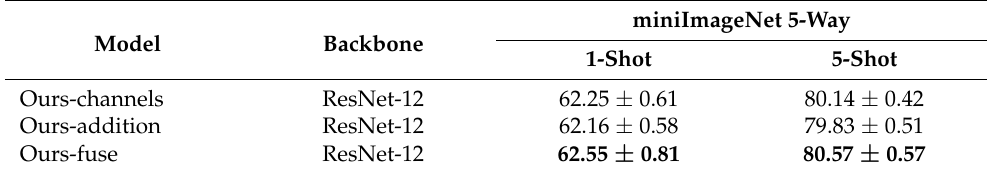
Table 4. Comparison of different feature fusion methods on the miniImageNet dataset. “Ours- channels” denotes fusing features directly by the same size of channels. “Ours-addition” denotes summing features from different stages and feeding them to other stages. Average meta-learning classification accuracies (%) with 95% confidence intervals on miniImageNet meta-test splits.